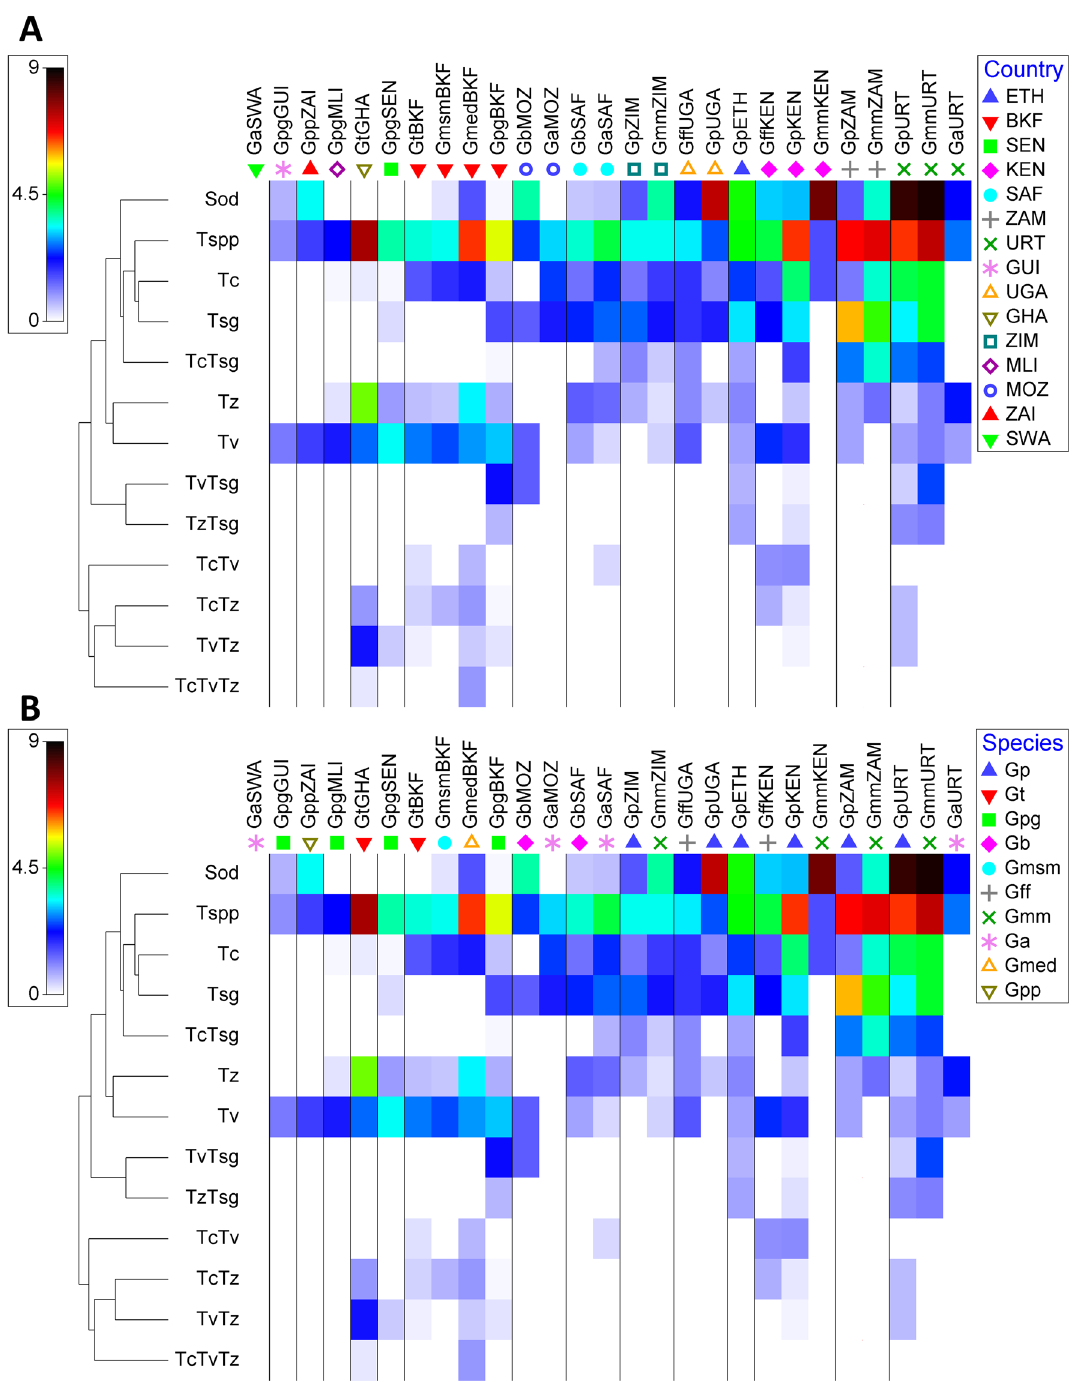
Figure 2. Prevalence of the Sodalis and Trypanosoma (single and multiple) infections per country ( A ) and tsetse species ( B ). Prevalence data were square root transformed and averaged based on country-species and the matrix display was conducted in PRIMER version 7 + software. Tree on the left of the matrix is the similarity dendrogram based on the similarity index of the square root of the prevalence values. The colour index is the square root of the prevalence values ranged 0–9 which is the square root of 0–81% prevalence. Country abbreviations follow the UNDP list of country codes https:// web. archi ve. org/ web/ 20060 71322 1355/ http:// refgat. undp. org/ gener iclist. cfm? entid= 82& pagen umber= 1& reque sttim eout= 360 as follows: BKF: Burkina Faso; ETH: Ethiopia; GHA: Ghana; GUI: Guinea; KEN: Kenya; MLI: Mali; MOZ: Mozambique; SAF: South